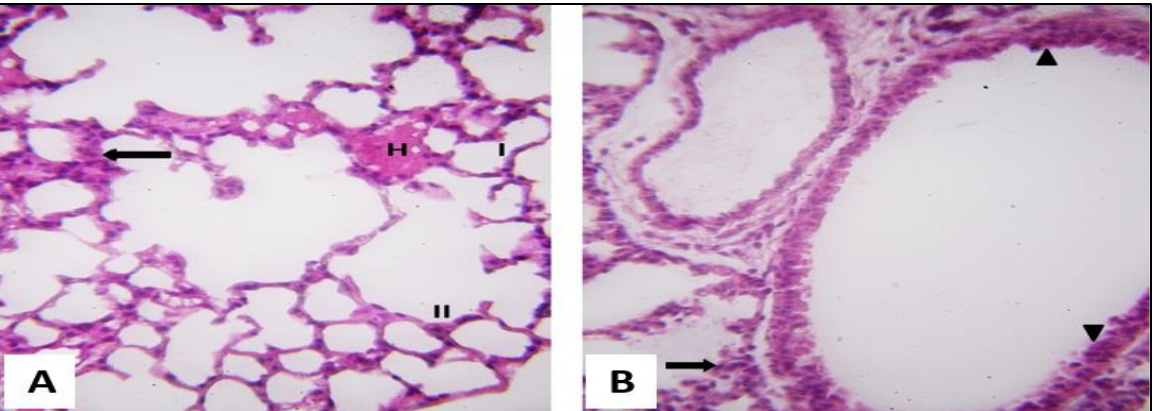
Figure 6. A rat lung section of group III (SCRE-treated) presenting the following features. ( A ) Thin interalveolar septa with patent alveoli. Pneumocyte type I (I) and type II (II) are noticed. Some alveoli contained homogeneous exudate (H). Few mononuclear cellular infiltrations ( ↑ ) are noticeable in some interalveolar septa (H&E, ×400). ( B ) A bronchiole shown with relatively intact epithelial lining ( ▲ ). Mononuclear cellular infiltrations (black arrow) are still present with interalveolar septa (H&E, ×400).